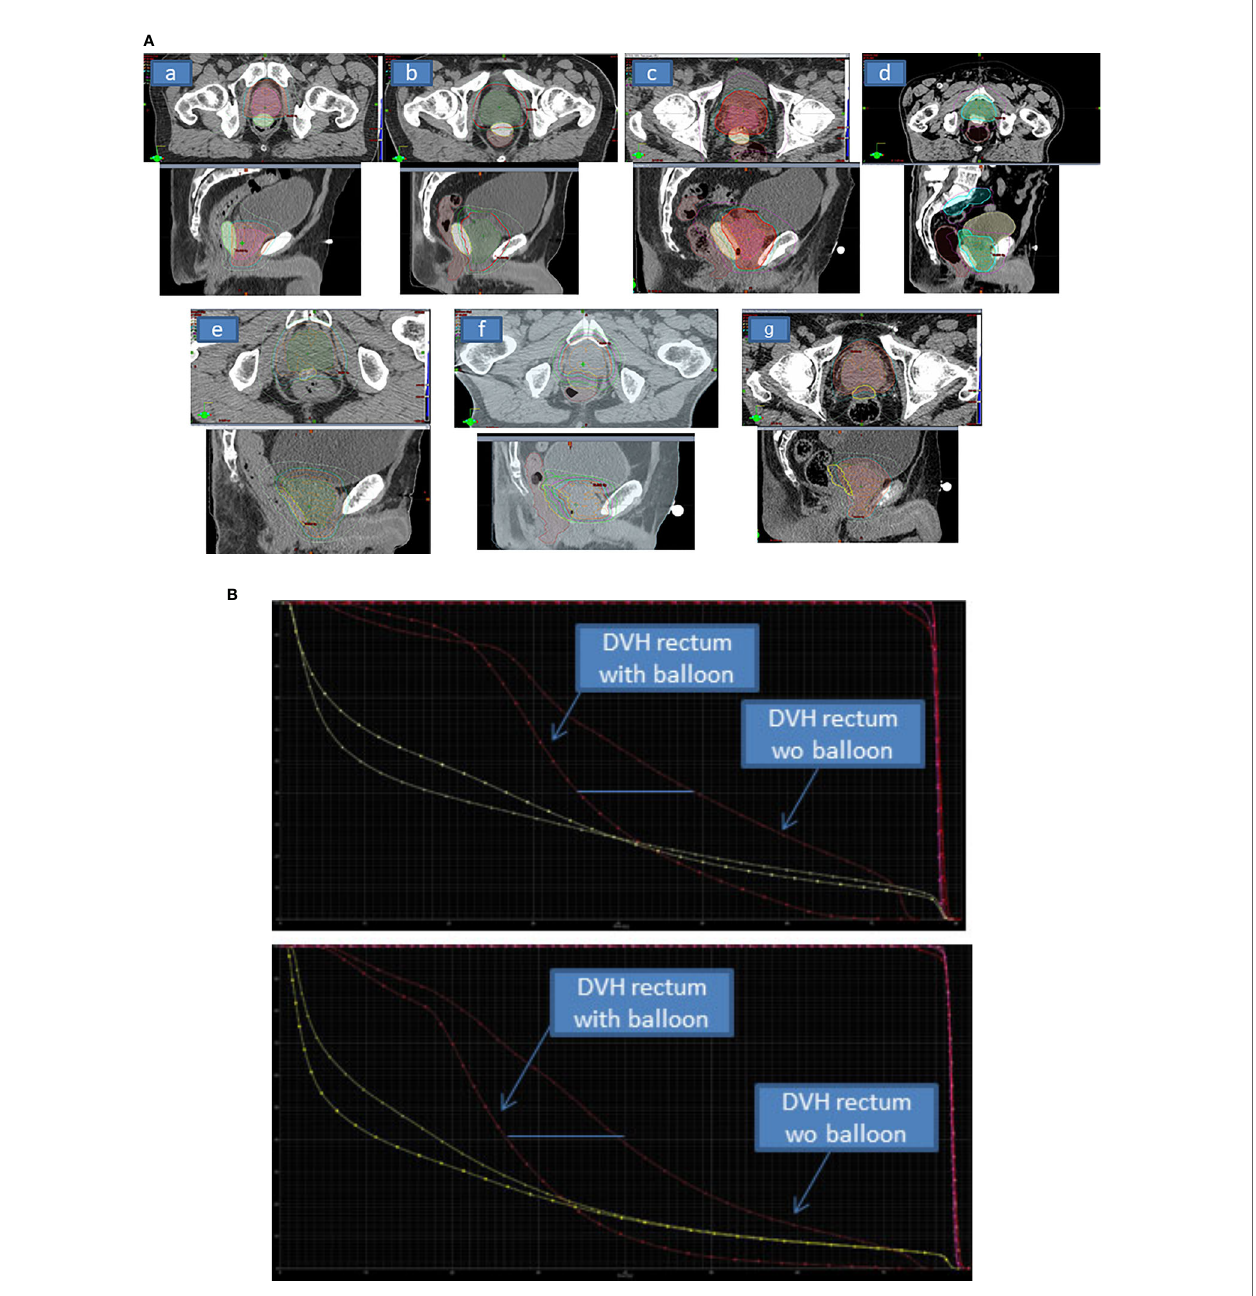
FIGURE 1 | (A) The planning CT axial and sagittal views of delineated volumes of interest (prostate gland and the ProSpace ® .biodegradable balloon) showing good quality of delineation with iodinated contrast- fi lling balloon (a – g). For 1 patient (e) iodine contrast product was too much diluted. For 2 patients (f, g), the procedure was performed without iodine contrast enhancement, and so delineation of the balloon was less easy. (B) The dose-volume histogram (DVH) for the rectum pre-balloon and post-balloon for 2 patients, showing the dosimetric bene fi t achieved with the balloon. The DVH for bladder (also shown, in yellow) is not modi fi ed. With regard to the clinical target volume and the planned treatment volume (shown in pink and red, respectively), balloon implantation was associated with greater